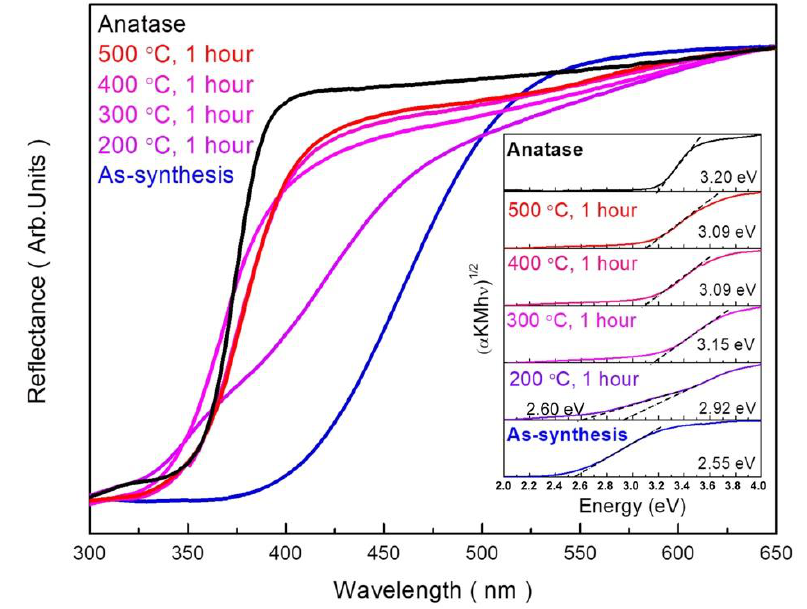
Figure 8. Reflectance spectra of PTNTs annealed at di ff erent temperatures. (Inset) Plots of ( α hv) 1 / 2 vs. energy for the annealed PTNTs at di ff erent temperatures.